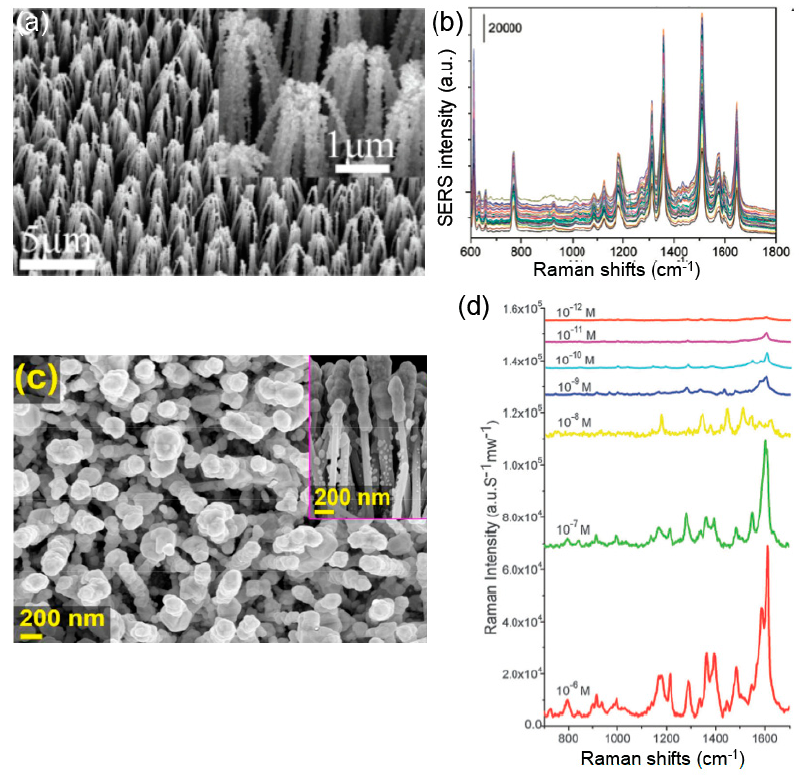
Figure 4. ( a ) SEM images of Au/ZnO nanoneedles and the insert is a zoom on a couple of nanoneedles; ( b ) SERS spectra of R6G molecules (C R 6 G = 10 − 7 M) adsorbed on Au/ZnO nanoneedles. ( a , b )